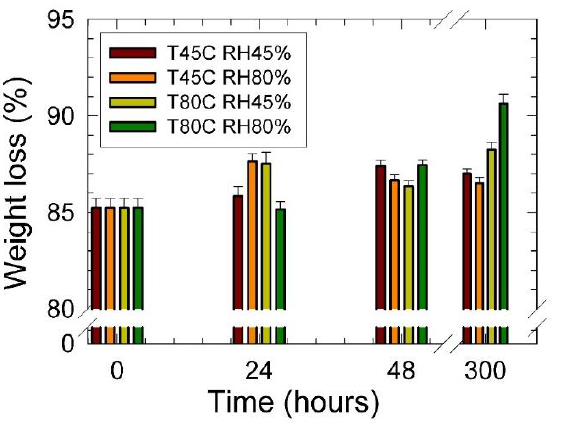
Figure 8. Weight loss vs. conditioning time of the studied PU foams. Inset: T — temperature (°C), RH — relative humidity (%).